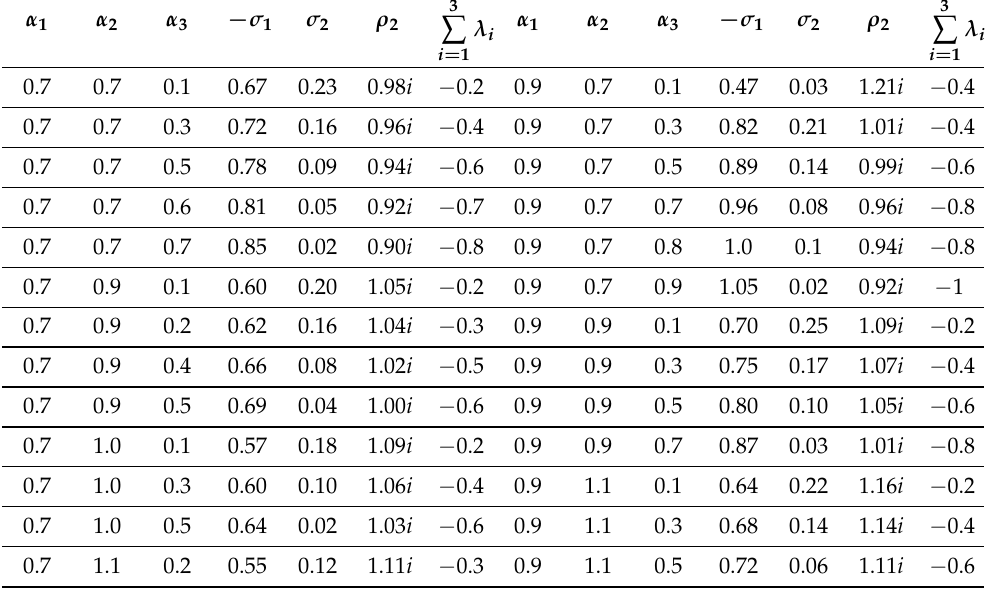
Table A1. Explored values in the electronic implementation of the deterministic Brownian-like motion